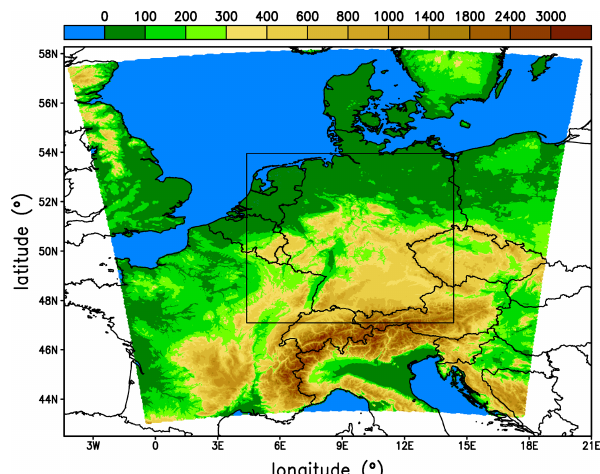
Figure 1. Cloud droplet size distributions for different values of the shape parameter ν at fixed cloud water content (QC) and cloud droplet number concentration (QNC). D denotes the diameter of the droplets.